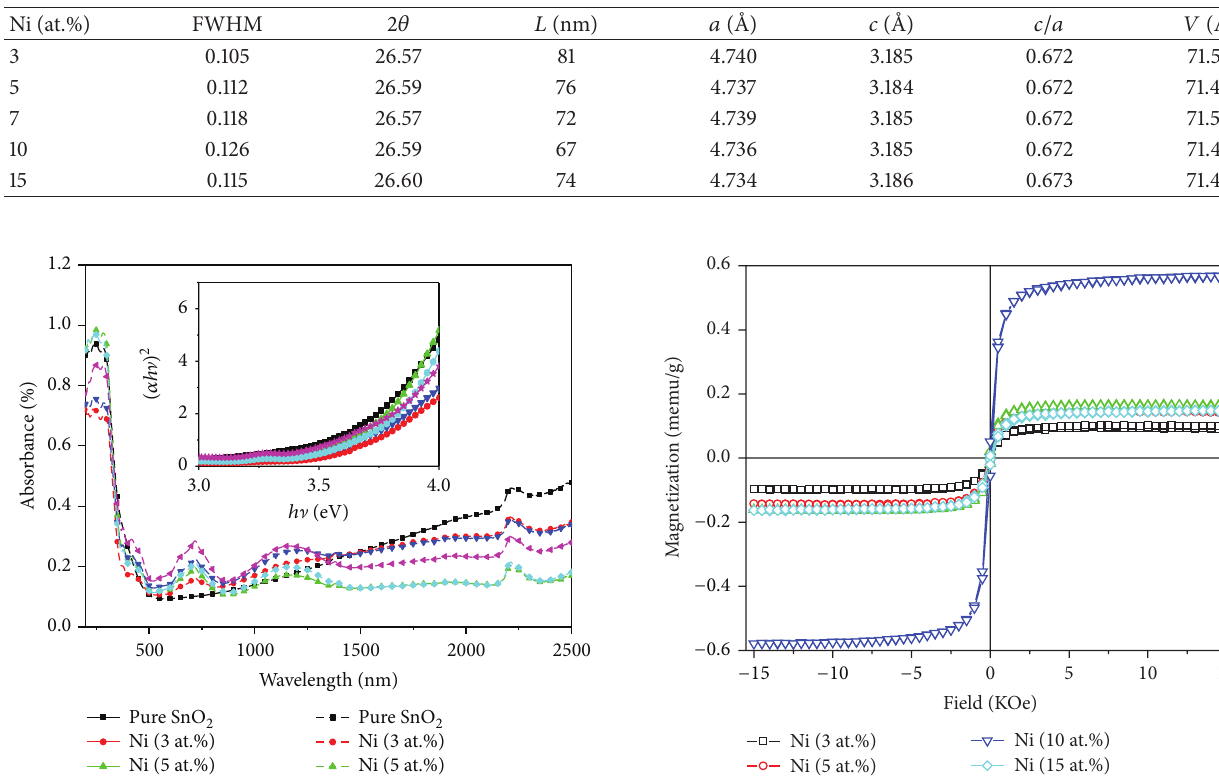
powder samples. 2